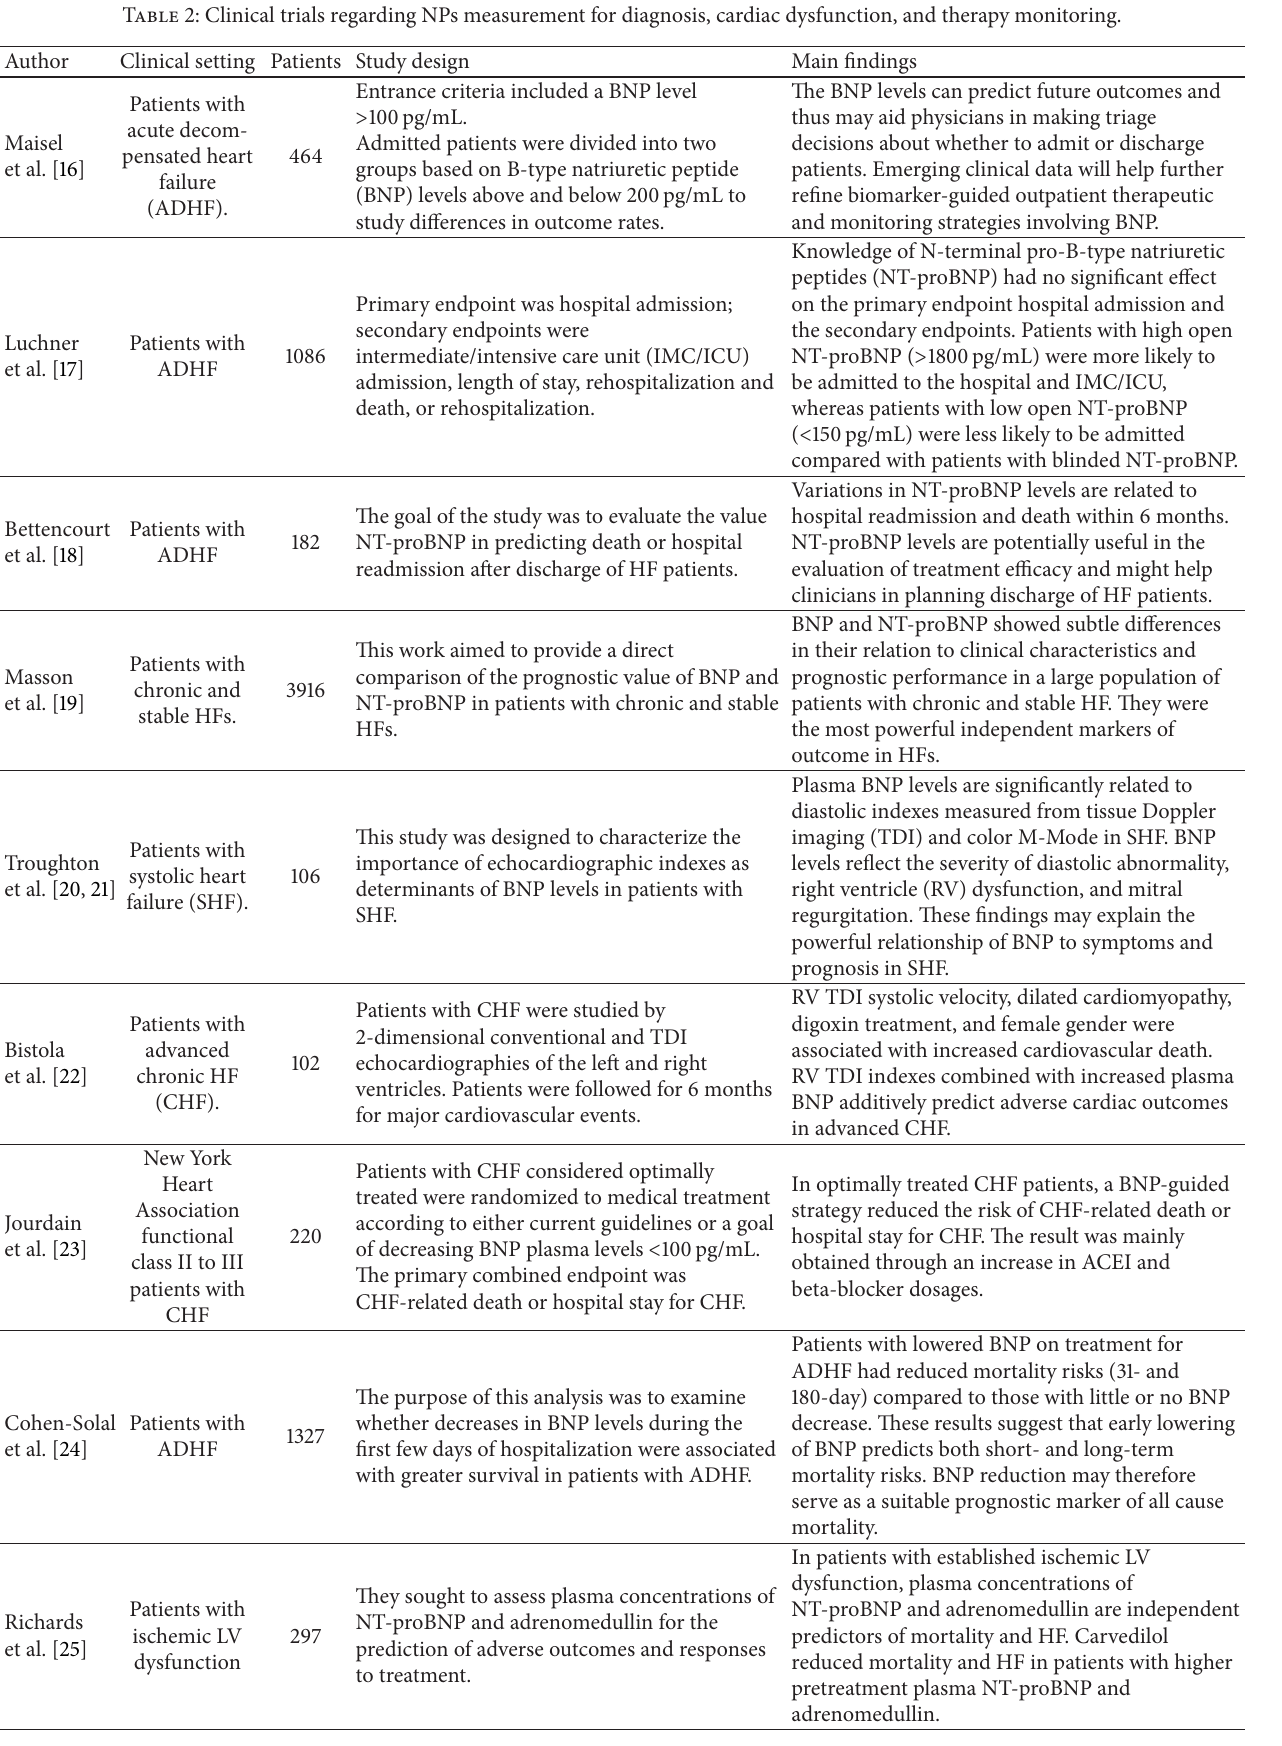
Table 2: Clinical trials regarding NPs measurement for diagnosis, cardiac dysfunction, and therapy